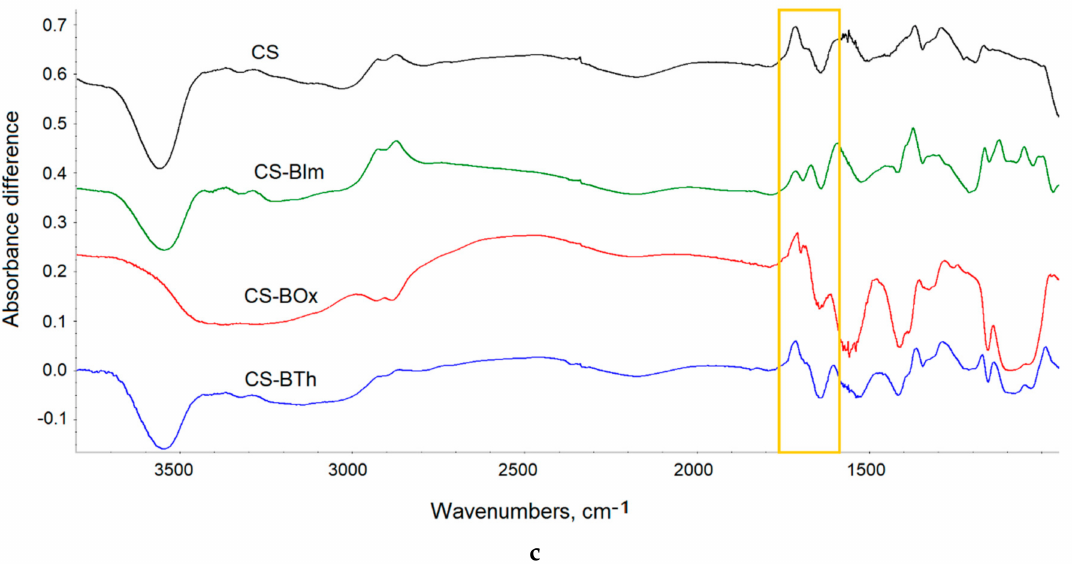
Figure 6. FTIR spectra of CS and its N-derivatives: at full IR range ( a ), at 1100–1800 cm − 1 range ( b ); difference spectra ( c ) obtained by subtraction of the spectrum of the unirradiated samples from the spectra of 8 h UV-irradiated samples. The yellow rectangles show the bands discussed in the text. In all figures ( a – c ), an offset was used to present the